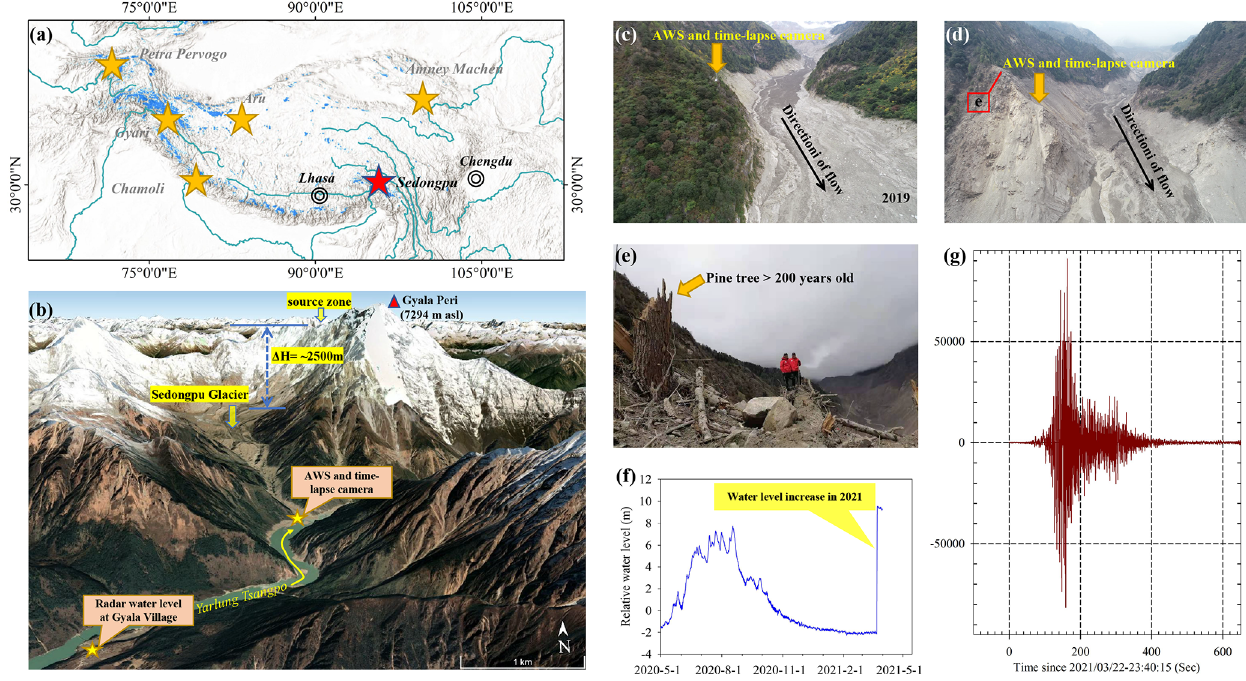
Figure 1. Overview of the Sedongpu basin, landscape modification, river blockage, and seismic waveform caused by the March 2021 ice- rock avalanche. (a) Location of the Sedongpu basin and the recent reported massive glacier detachments and ice-rock avalanches in High Mountain Asia. (b) © Google Earth image (images on 14 December 2017, CNES/Airbus and Maxar Technologies) showing topographic condition of the Sedongpu basin, the location of hazard cascade area, and the ground-based observations (yellow stars). (c, d) Photographs showing the same view in October 2019 (pre-event) and on 25 March 2021 (post-event) looking into the Sedongpu valley. The photos show the location of an AWS and time-lapse camera ∼ 150m above the valley floor close to the valley outlet (see panel b ), which were destroyed by the March 2021 event. (e) Photograph showing a mass flow-overtopped hill where the monitoring station was installed. (f) The sudden water level rise caused by the Yarlung Tsangpo river blockage on 22 March 2021. (g) Seismic waveform recorded at the Nyingchi station, 60km away from Sedongpu basin starting at 23:40:15 on 22 March